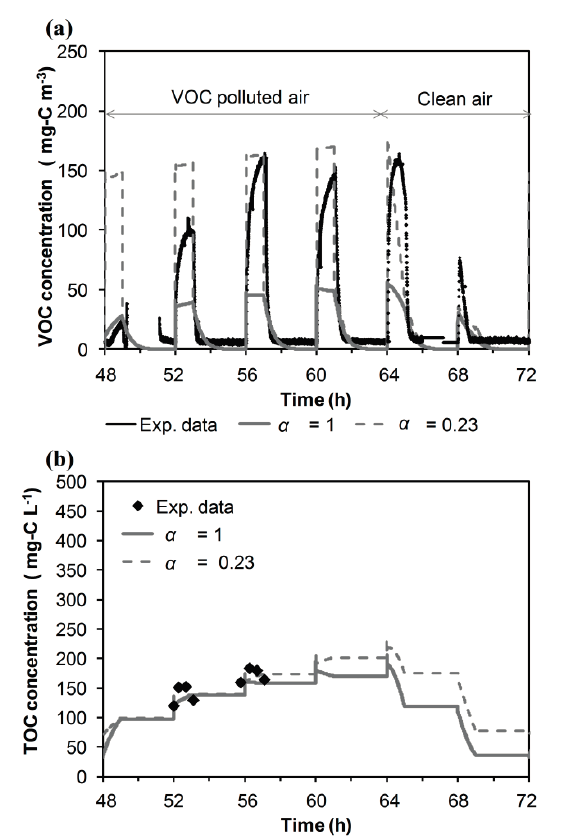
Figure 3. Influence of the parameter α 1 on the model predictions of Wednesday data (Run 1). ( a ) Outlet concentration of VOC in the gas phase. ( b ) Concentration of the dissolved carbon in the water